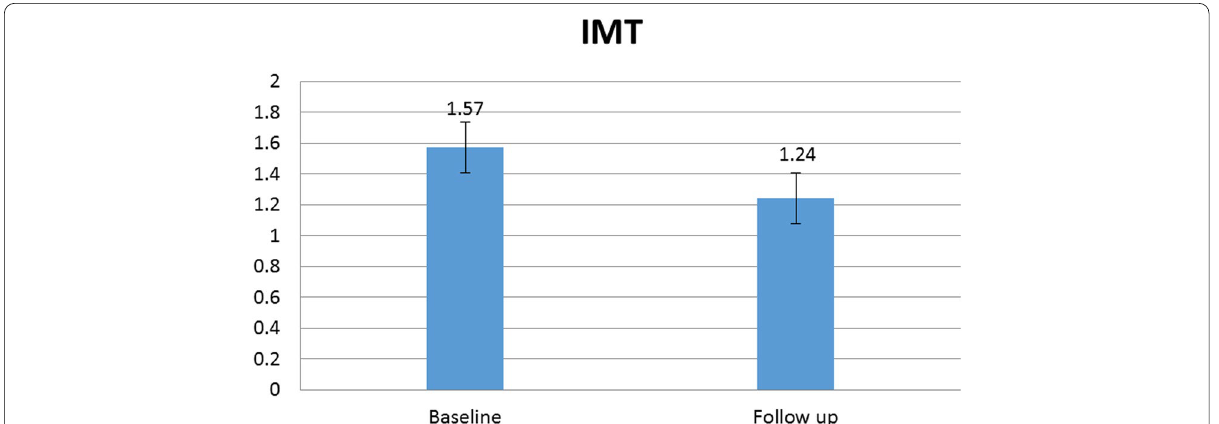
Fig. 1 Comparison between IMT at baseline and follow-up. The number of patients who had IMT follow-up 45 (56.3%) compared to baseline 57